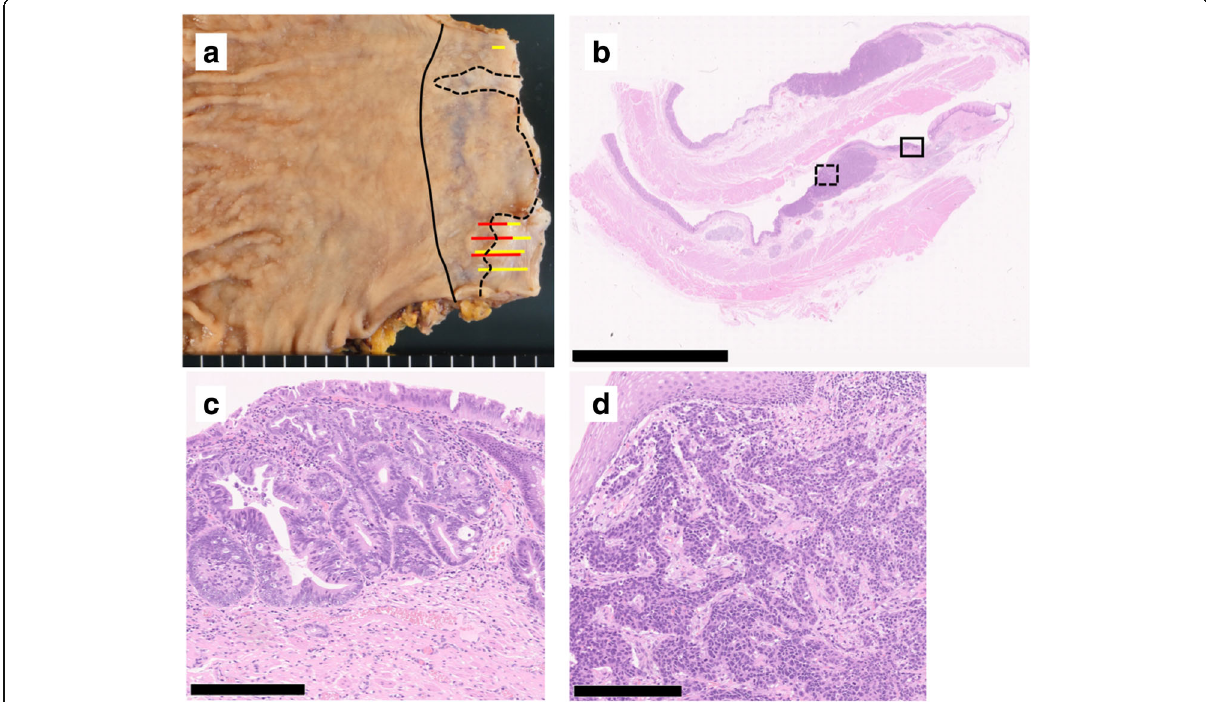
Fig. 3 Histological findings of MANEC. Macroscopically, a type 0-IIa + IIc lesion measuring 25 × 10 mm was detected in the esophagogastric junction. The black solid line indicates the esophagogastric junction, the black dotted line the squamocolumnar junction, the yellow line the adenocarcinoma component, and the red line the NEC component ( a ). A loupe image of the lesion is shown ( b , scale bar 10 nm). The solid rectangle indicates well differentiated adenocarcinoma ( c scale bar 250 μ m), and the dotted rectangle indicates an area of proliferation of round- shaped carcinoma cells with hyperchromatic nuclei and scant cytoplasm in a nested pattern, indicative of small cell NEC ( d scale bar 250 μ